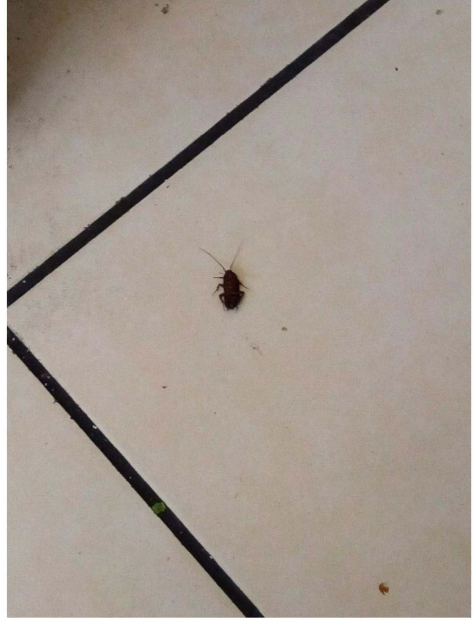
Figure 10. “Cockroach”—Participant.Survey11.